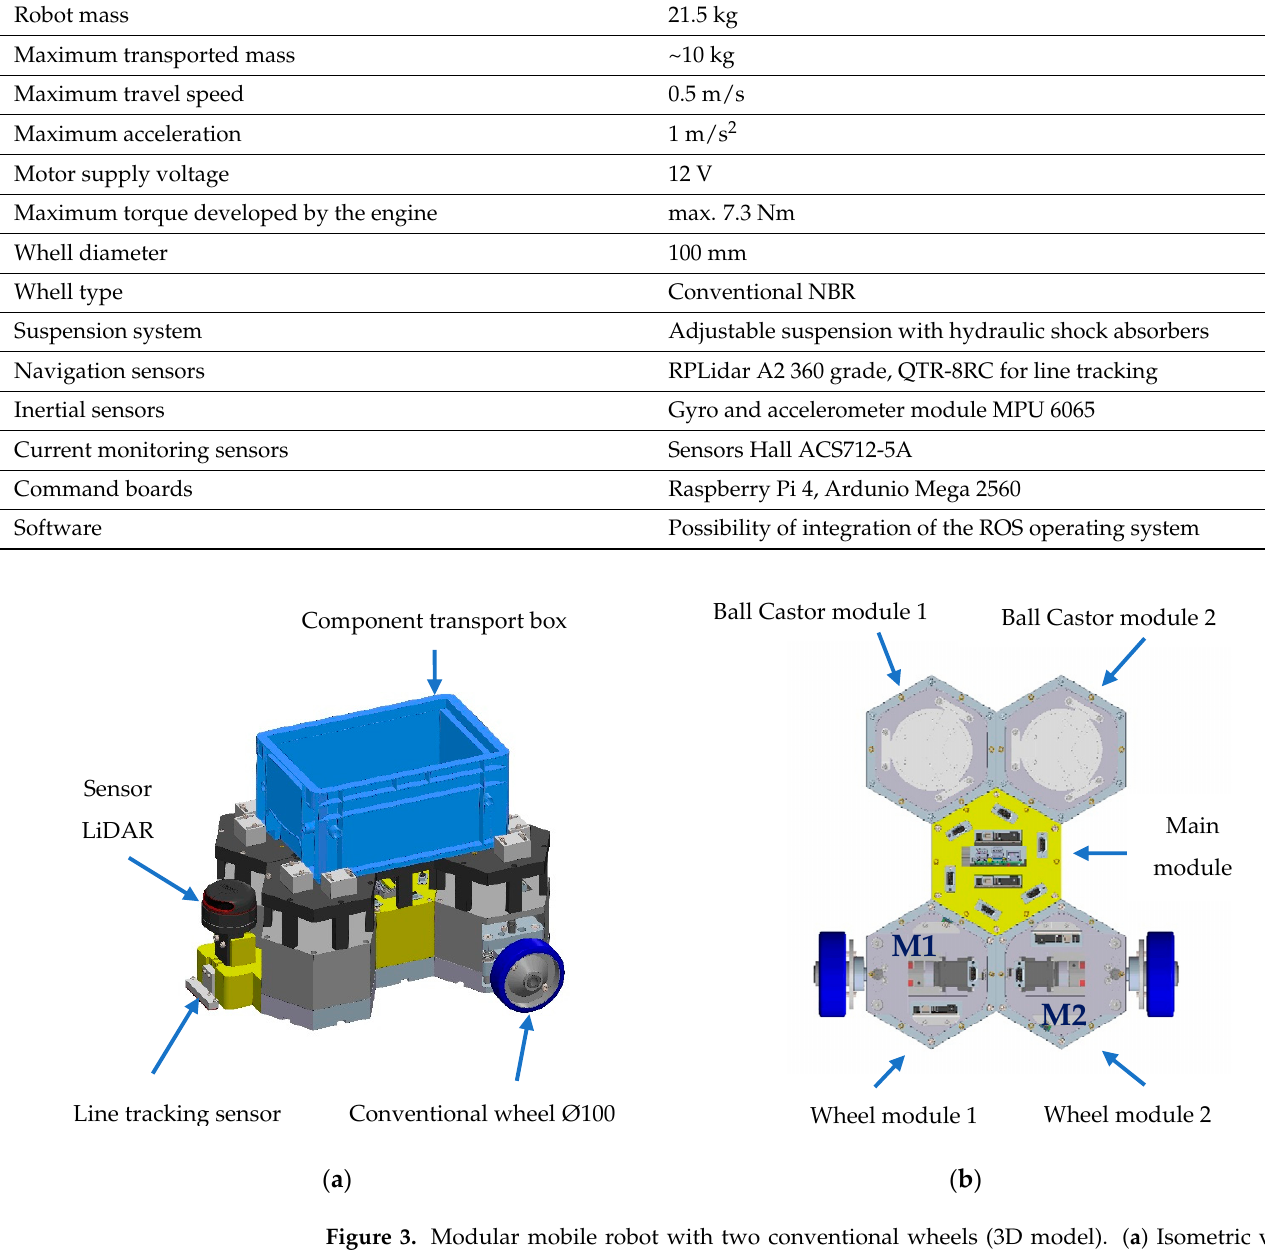
( b ) Figure 4. Modular mobile robot with two conventional wheels (real model). ( a ) Isometric view. ( b ) Bo tt om view. 2.3. Characteristics of the Dynamixel MX 64 AT Servomotor The actuation system of the modular mobile robot is the drive wheel module illus- trated in Figure 5, where the construction and main components of the module are pre- sented.